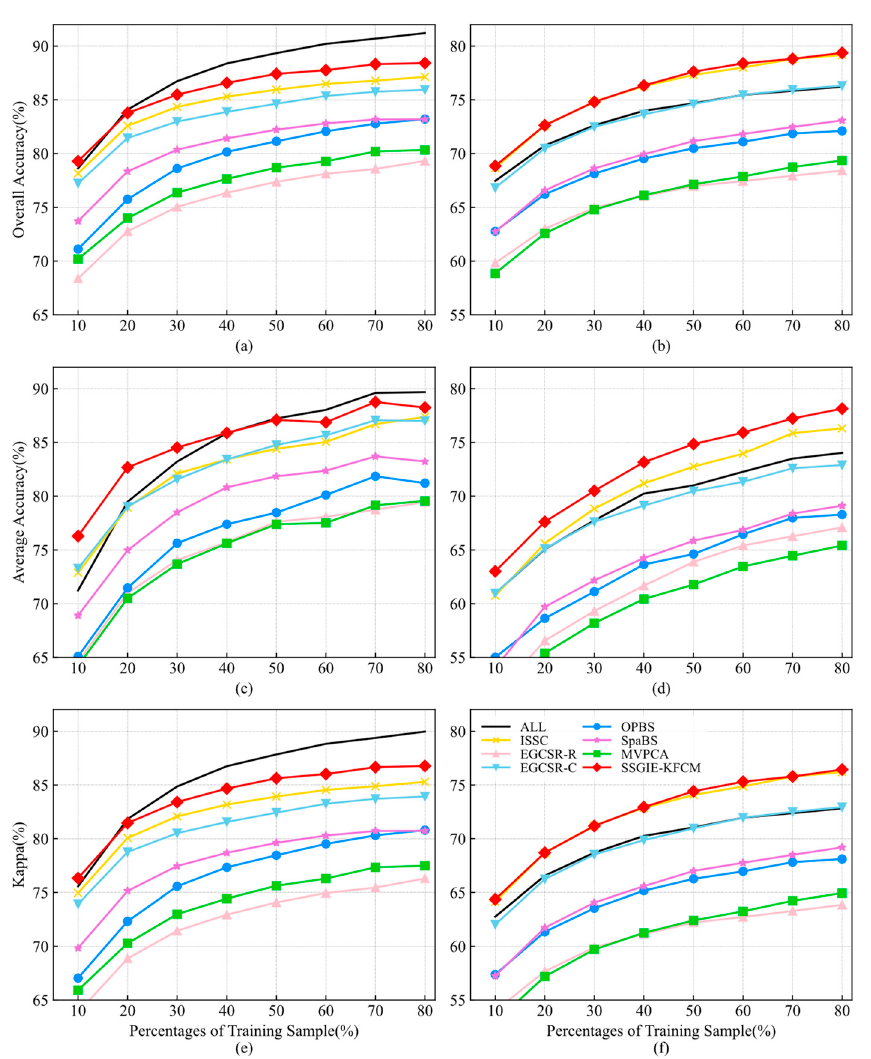
Figure 8. Classification accuracy of different band selection methods using the Indian Pines dataset with 28 bands and different training sample sizes. ( a , c , e ) are SVM classifiers; ( b , d , f ) are KNN clas- sifiers.